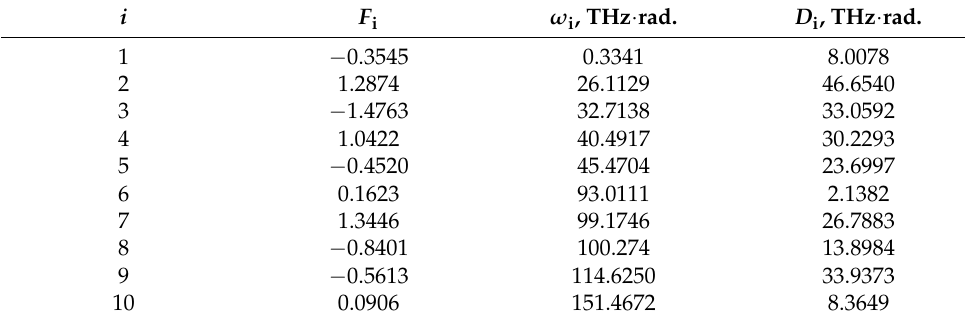
Table 2. Parameters for the Raman function used in the simulation.